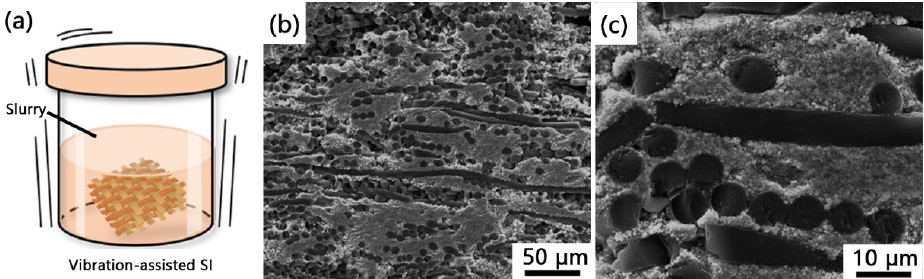
Fig. 18 Schematic diagram of vibration-assisted slurry impregnation (a); microstructures of the C f /ZrB 2 –SiC composites fabricated by vibration-assisted slurry impregnation (b, c). Reproduced with permission from Ref. [176], © Elsevier Ltd.